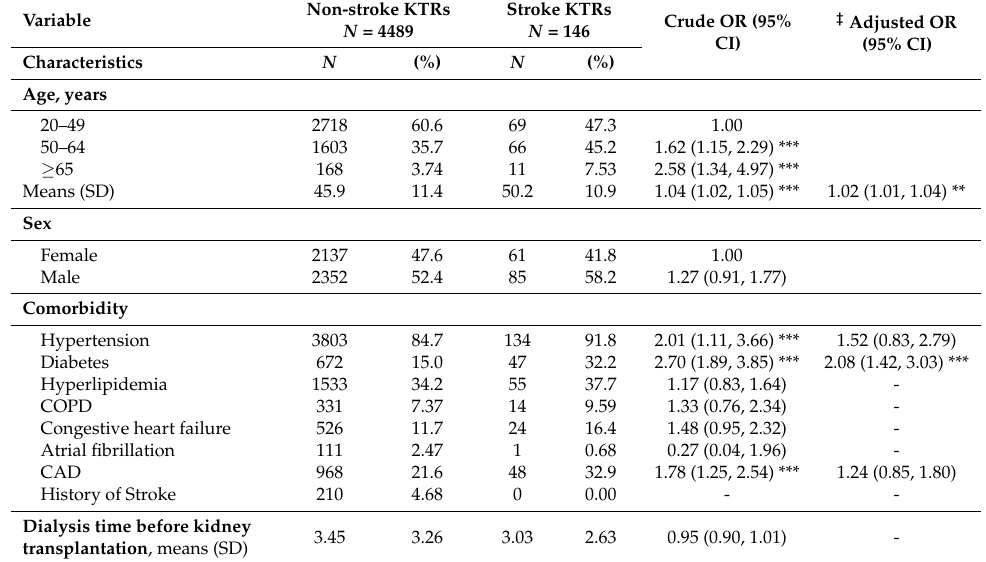
Table 5. Descriptive characteristics of KTRs with and without stroke and odds ratios and 95% confidence intervals for stroke associated with descriptive